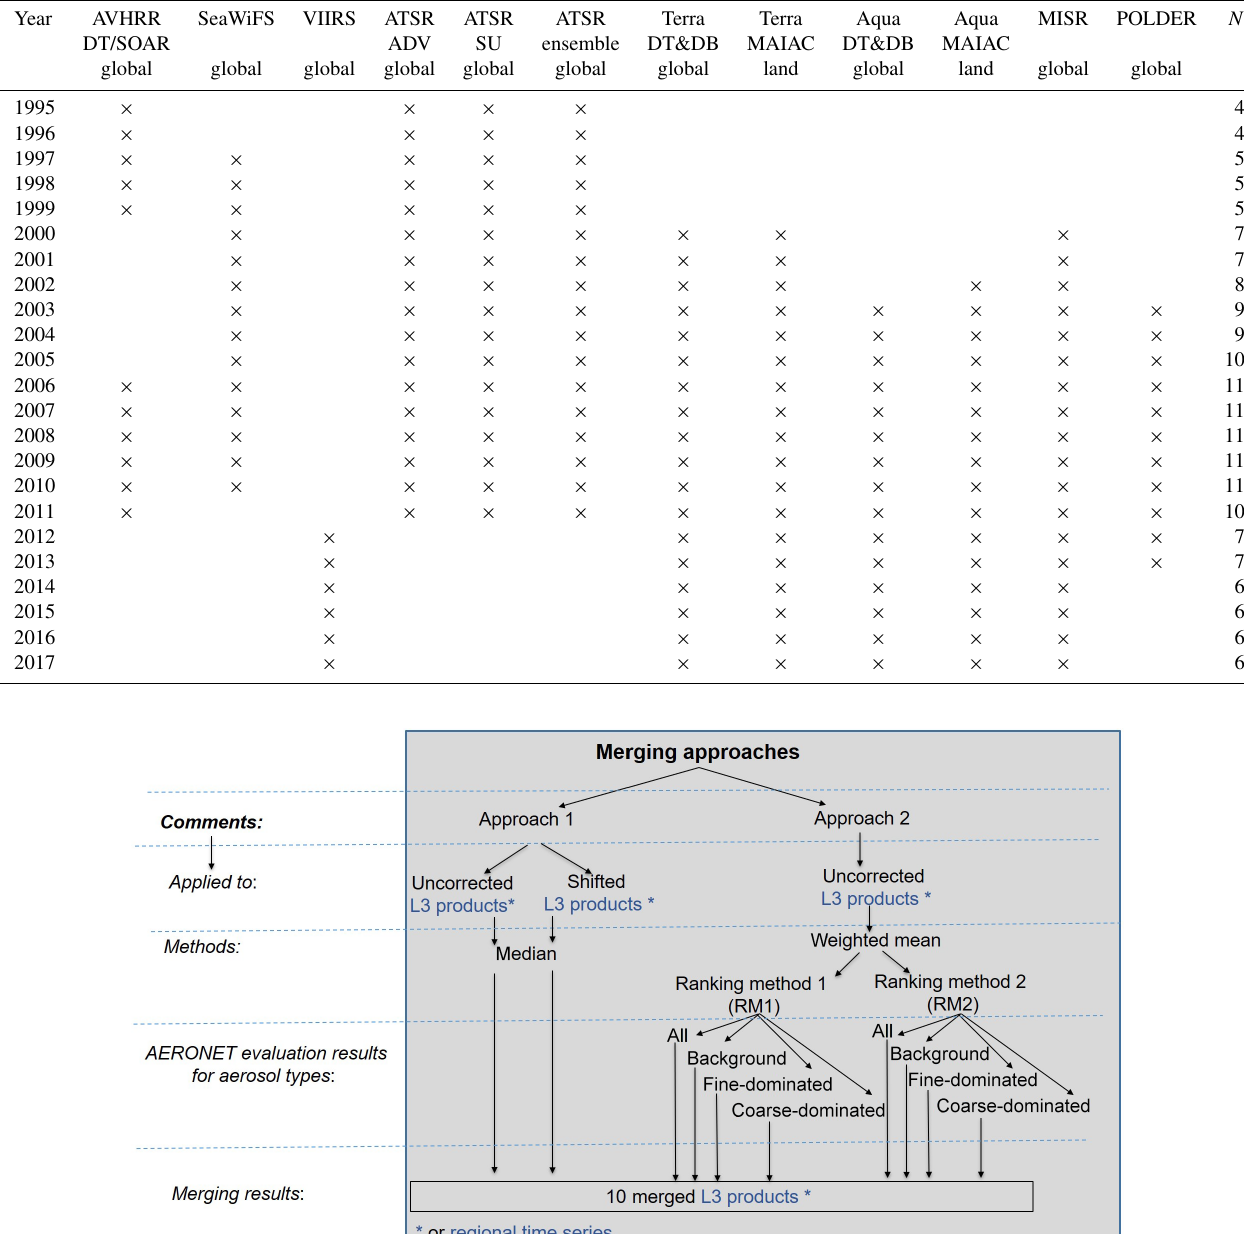
Table 2. Availability and coverage of the AOD products for merging for each year in the period 1995–2017. N : annual number of available products.